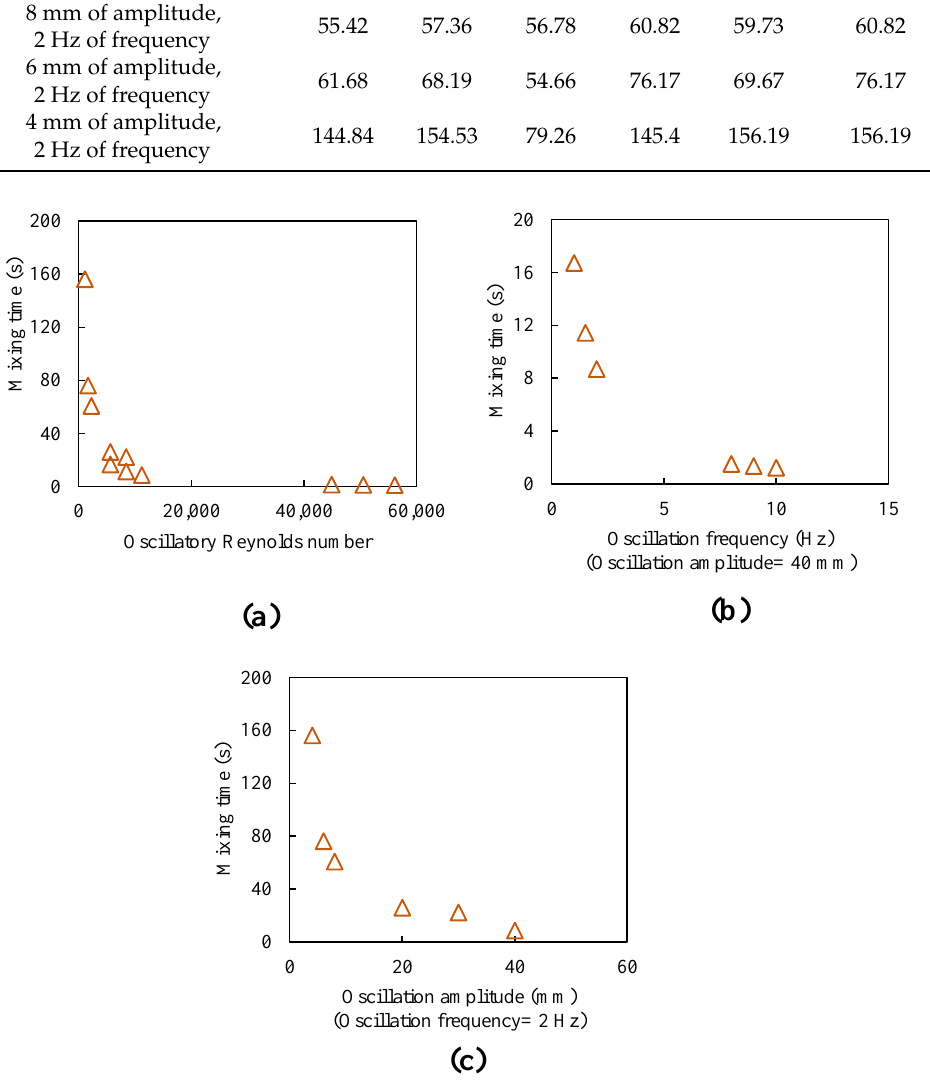
Figure 9. Mixing time versus ( a ) oscillatory Reynolds number, ( b ) oscillation frequency, ( c ) oscillation